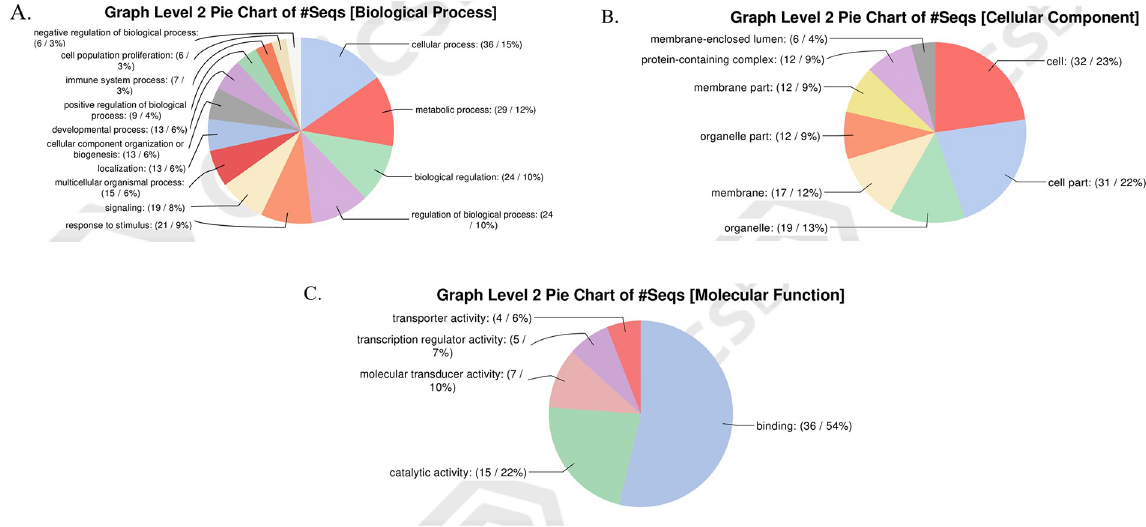
Fig 3. Functional classification of genes in forward library. (A) Classification of biological processes level. (B) Classification of cell component level. (C) Classification of molecular function level.